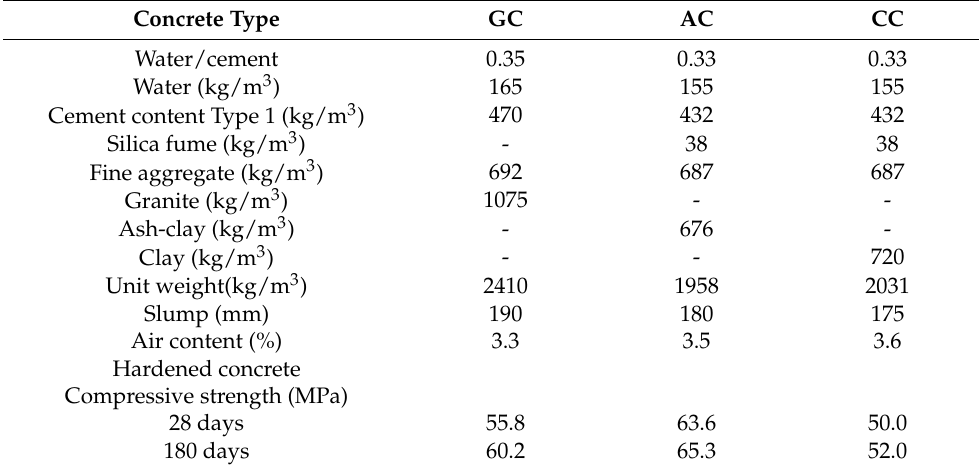
Table 4. Proportion of the concrete mixtures and properties of the fresh concrete.